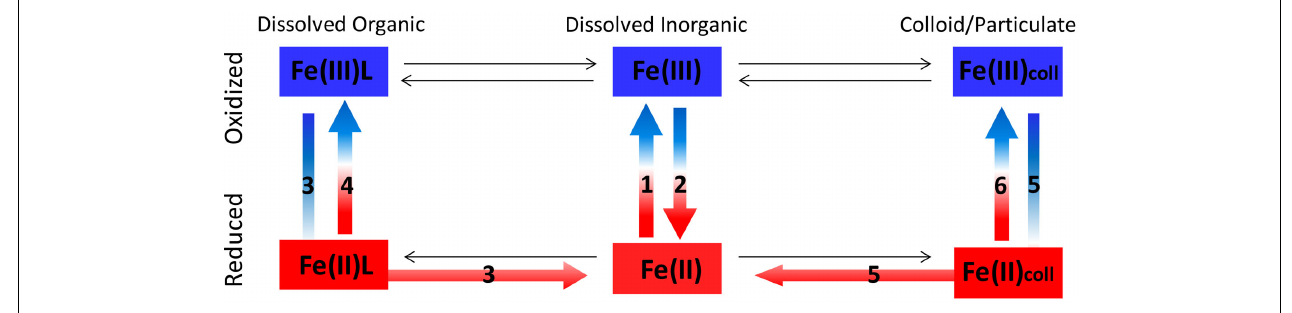
FIGURE 7 | Redox reactions of different Fe species in aquatic environments. See Table 2 below for details on processes 1–6 in the figure.